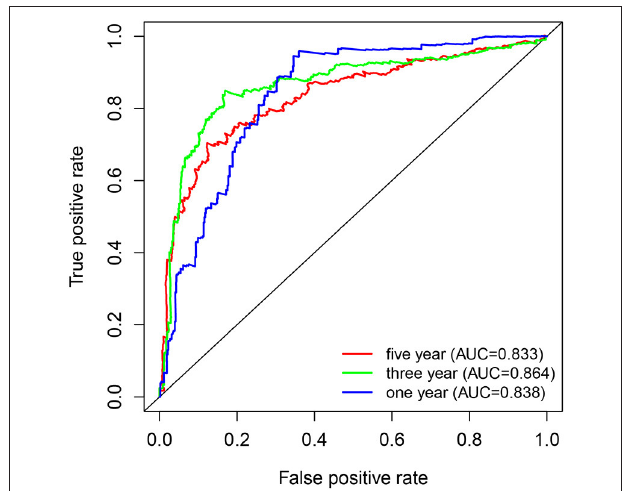
FIGURE 4 | ROC curves of PYGL expression in predicting 1-, 3- and 5-year survival of glioma patients.